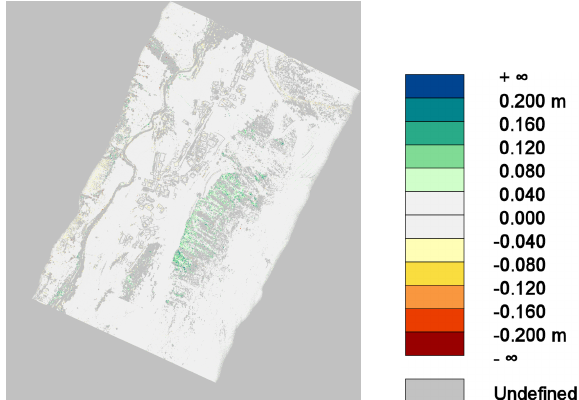
Figure 4: Differences in ranging between on-board range estima- tion of the sensor and FWF analysis using Gaussian Decomposi-